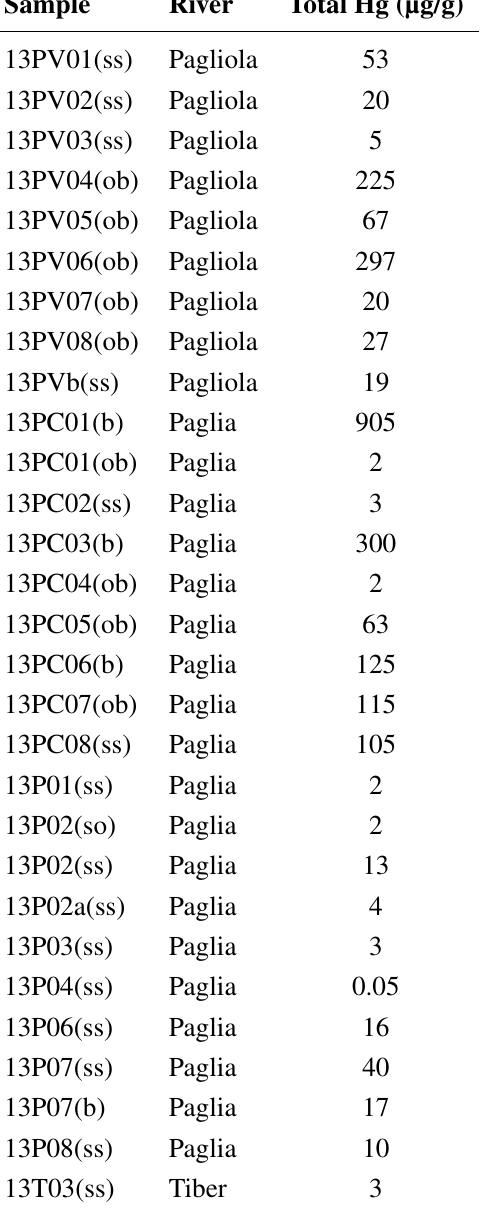
Table 2. Total mercury concentrations for stream sediment (ss), soil (so), bank (b) and overbank (ob) collected along Paglia River after the November 2012, flood